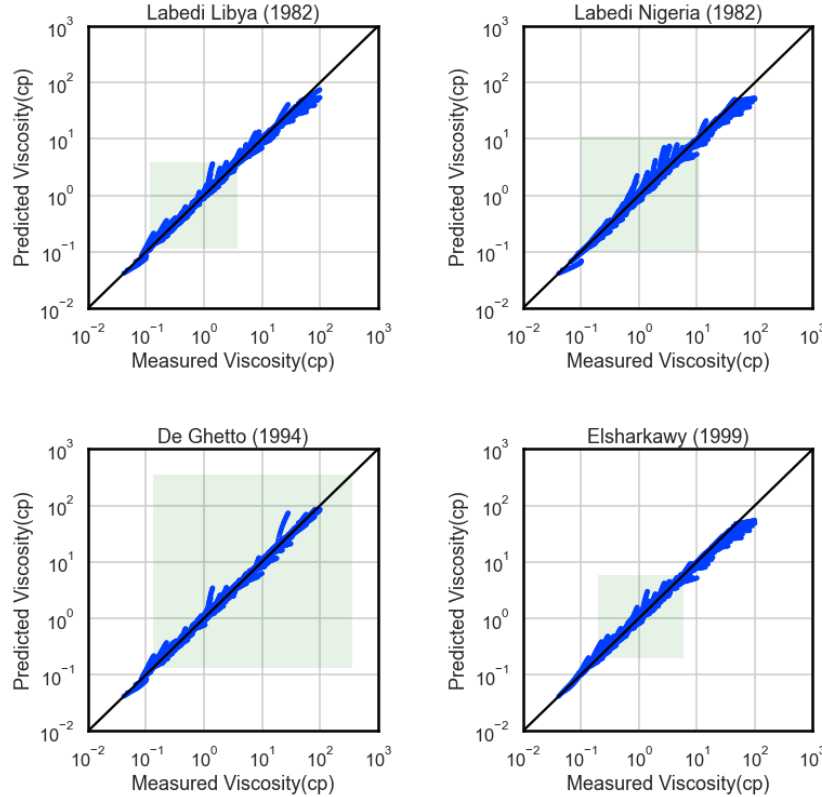
Figure A3. Parity plots of correlations in cluster B 1